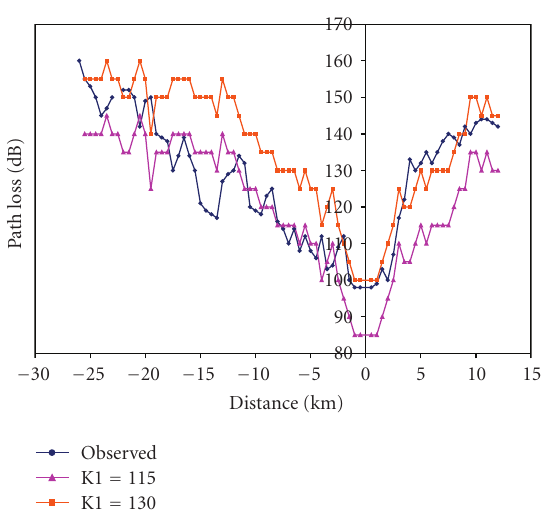
Figure 8: Comparison of tool predicted losses with observed losses versus track distance for Vangani base